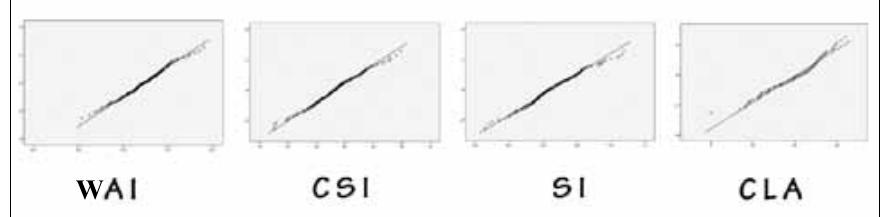
Figure 6. Distribution of Q-Q Plots of Williams, CSI, SI indexes and Clarke’s